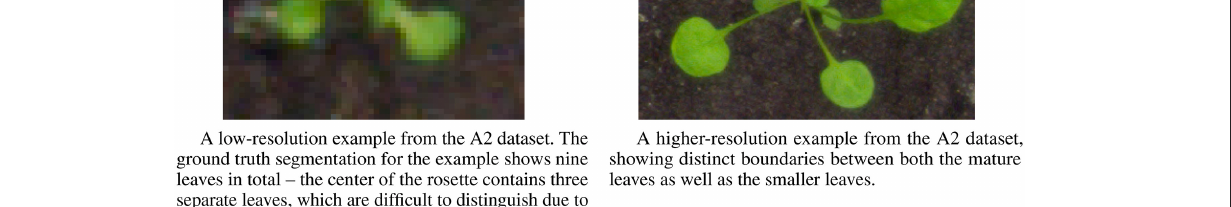
Frontiers in Plant Science |